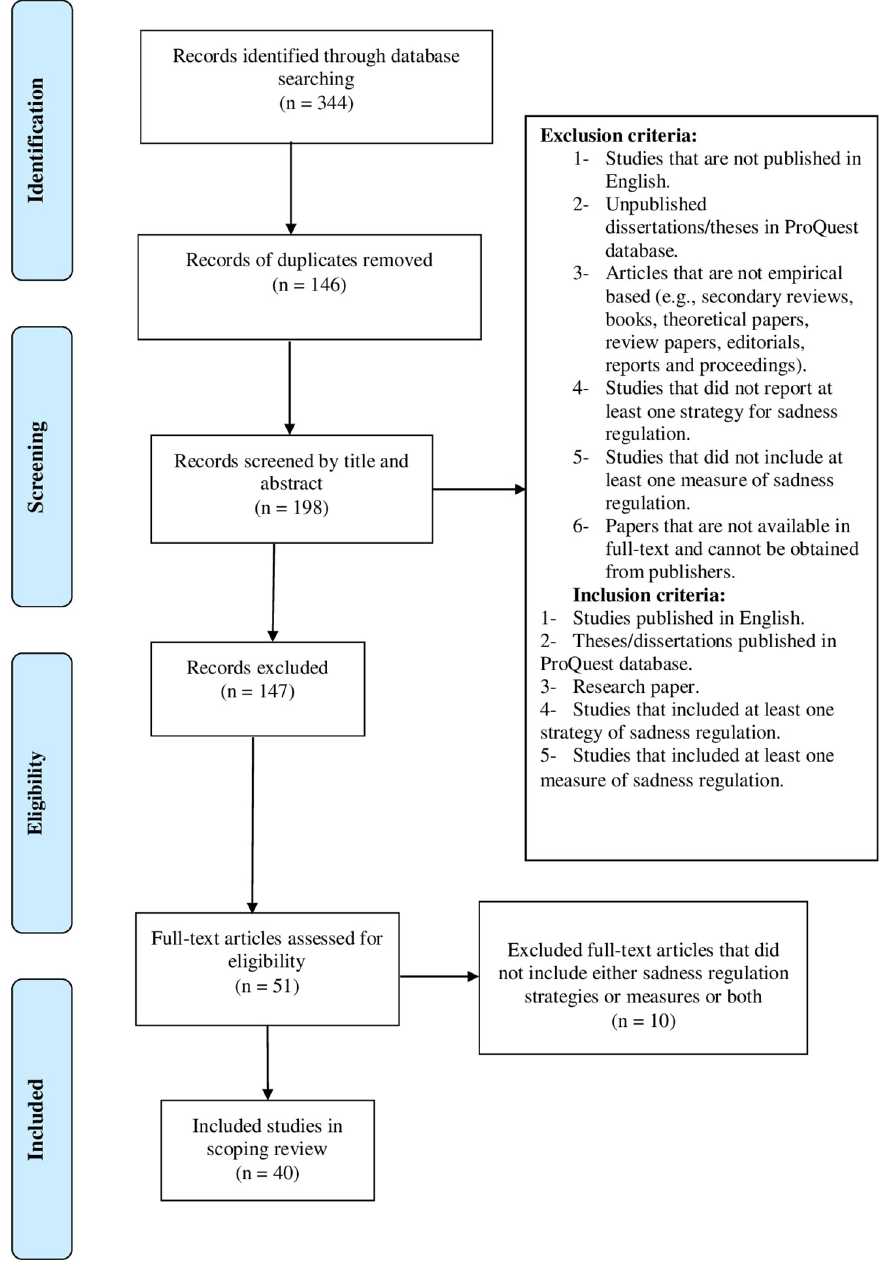
Fig 2. Prisma flow diagram illustrates the process of selecting articles for